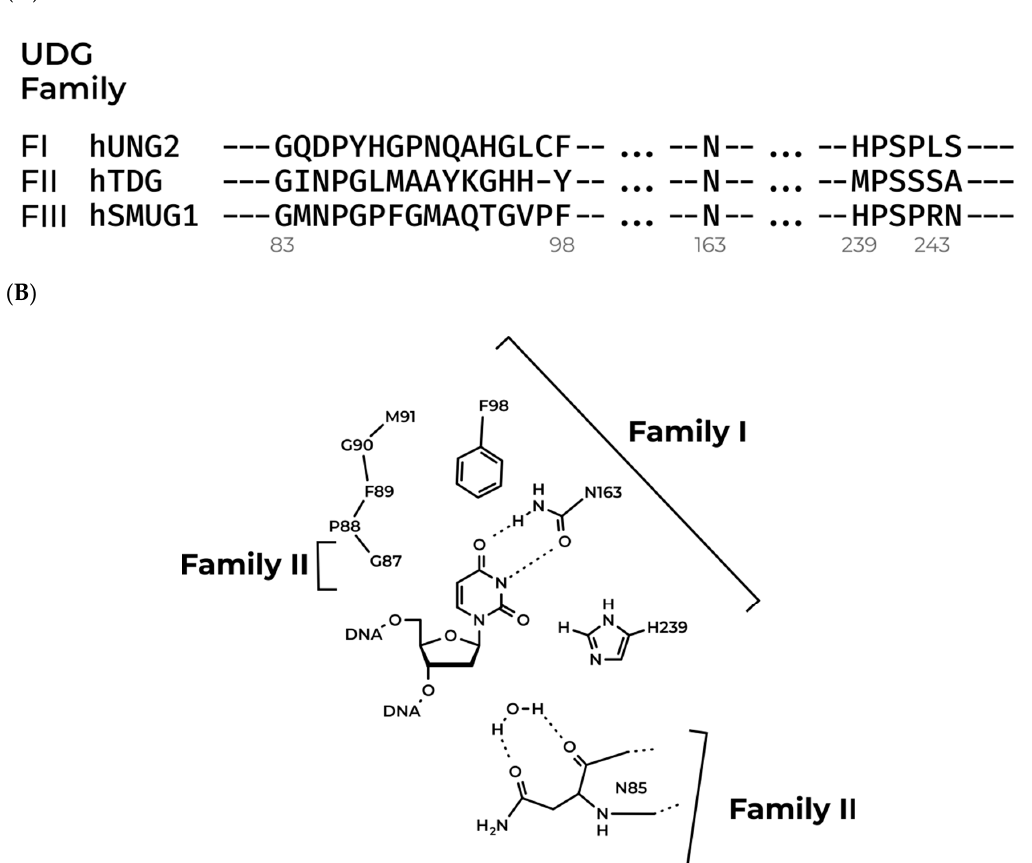
Figure 1. ( A ) Conserved motifs of the uracil–DNA glycosylase superfamily. ( B ) Interactions of the functionally important residues in the active-site pocket of hSMUG1, which is a hybrid of family I and II [11].